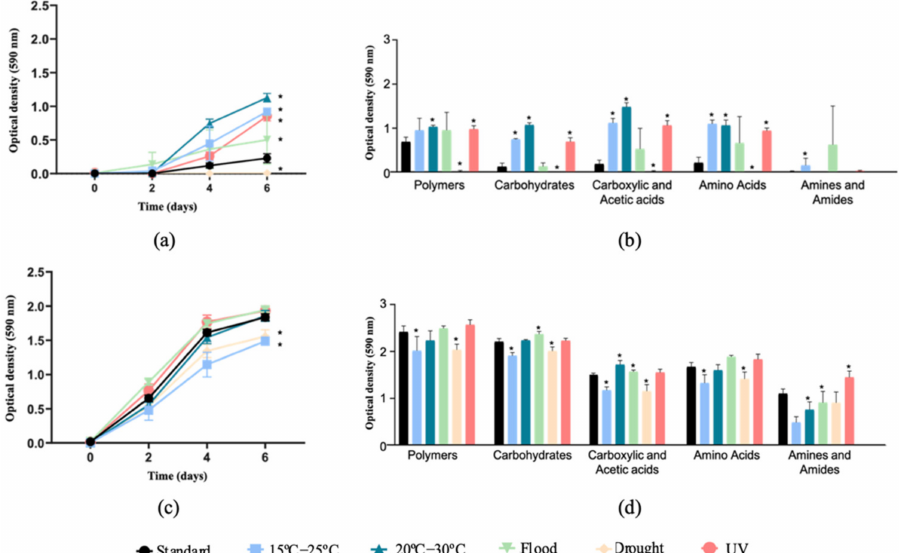
Figure 1. Community-level physiological profiles based on average well color development (AWCD, a , c ) and substrate average well color development (SAWCD, b , d ) of Lufa 2.2 soil without ( a , b ) and with ( c , d ) the presence of the soil invertebrate E. crypticus . After exposure to the different scenarios for 48 h, microbial catabolic activity was evaluated for 6 days. ( b , d ) show substrate consumption at the end of the 6 days. Values are average ± standard deviation ( n = 5). Standard refers to the conditions recommended by the standardized OECD guidelines. The symbol * indicates statistical differences compared to standard conditions based on one-way ANOVA followed by Dunnett’s post hoc test ( p < 0.05). UV